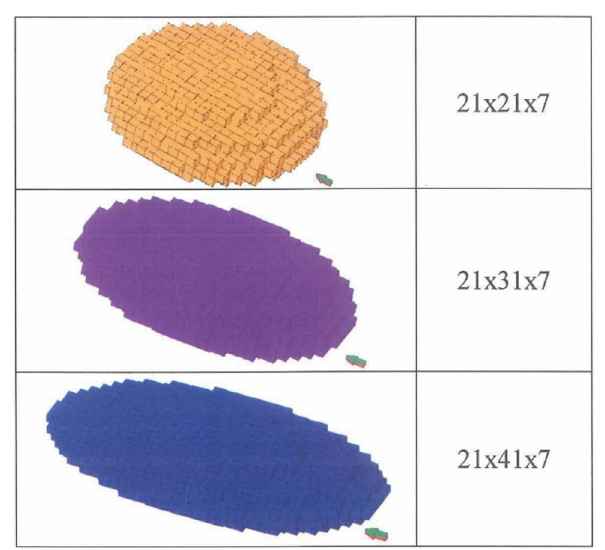
Fig. 18 Search mask with different sizes is used